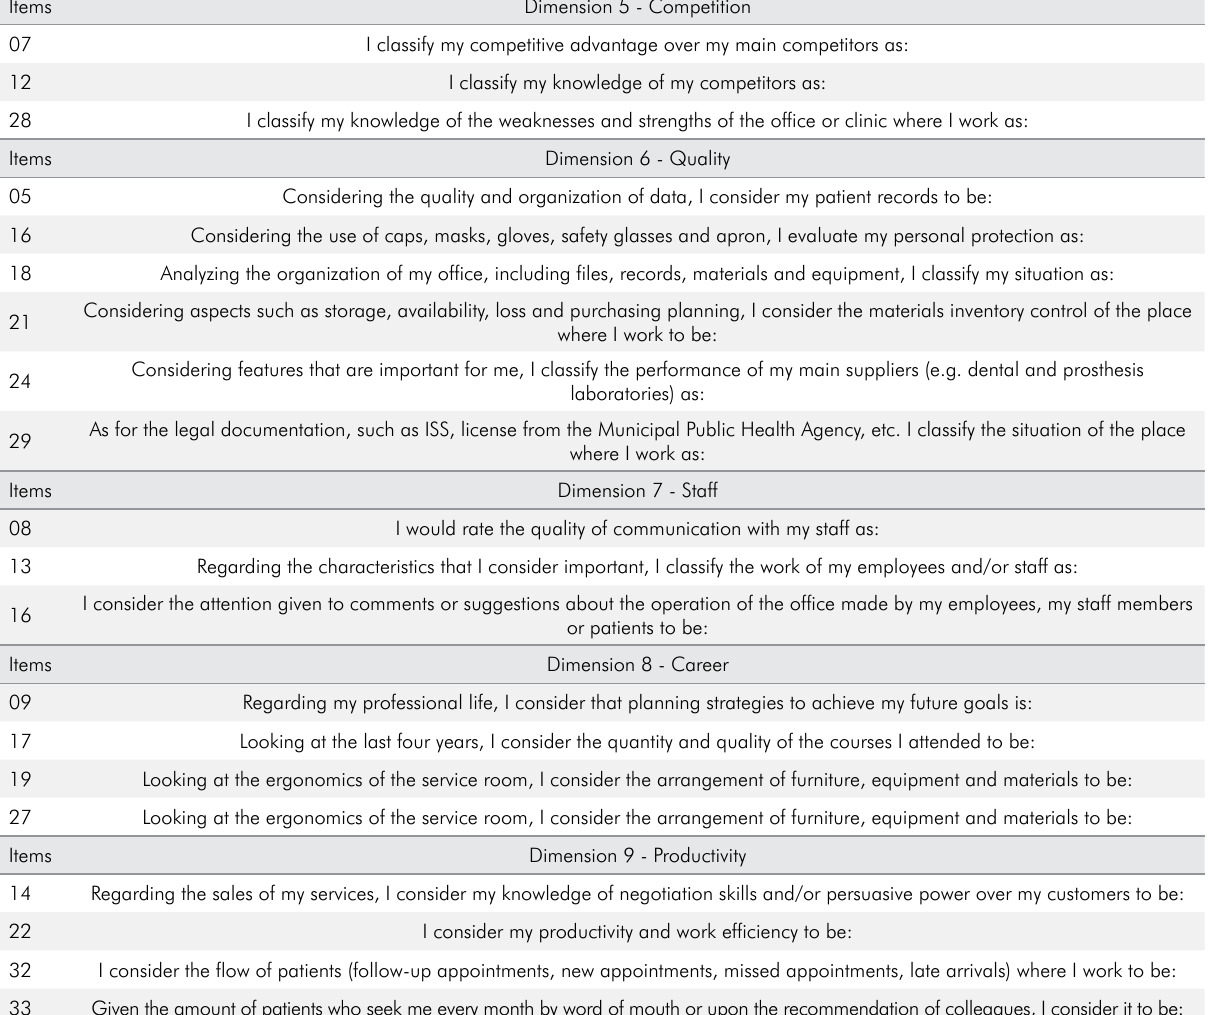
Table 2. DMS-BR: dimensions 5 to